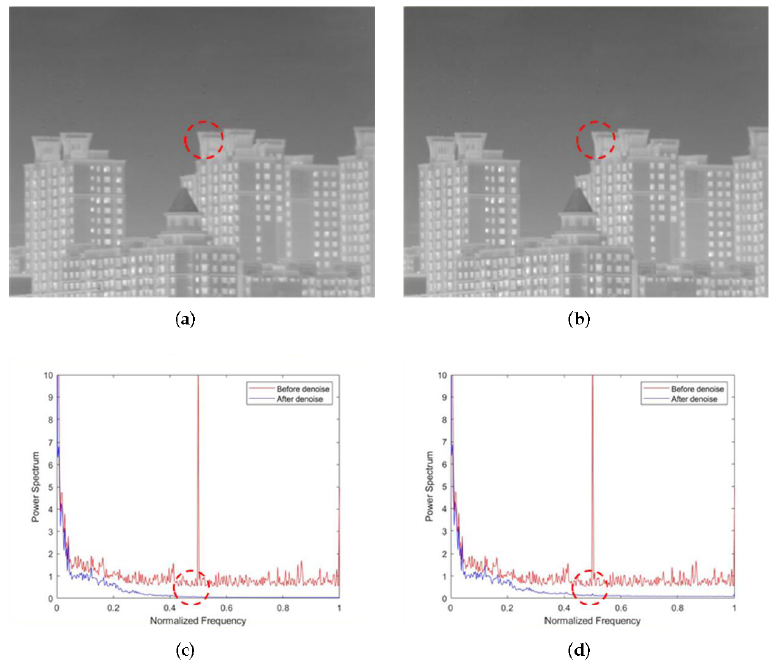
Figure 8. Denoising effects of ablation experiment on an image of buildings against the sky: ( a ) non-AEPO; ( b ) our approach; ( c ) non-AEPO; ( d ) our